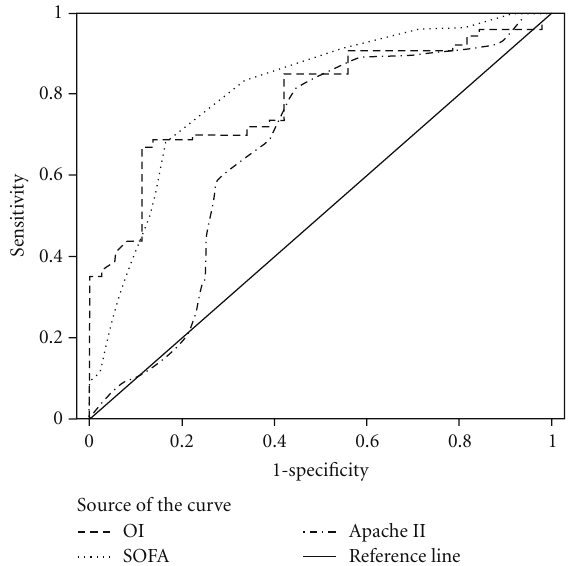
Figure 1: ROC curve analysis for predictability of ventilator dependence between SOFA score, APACHE IIscore and OI.